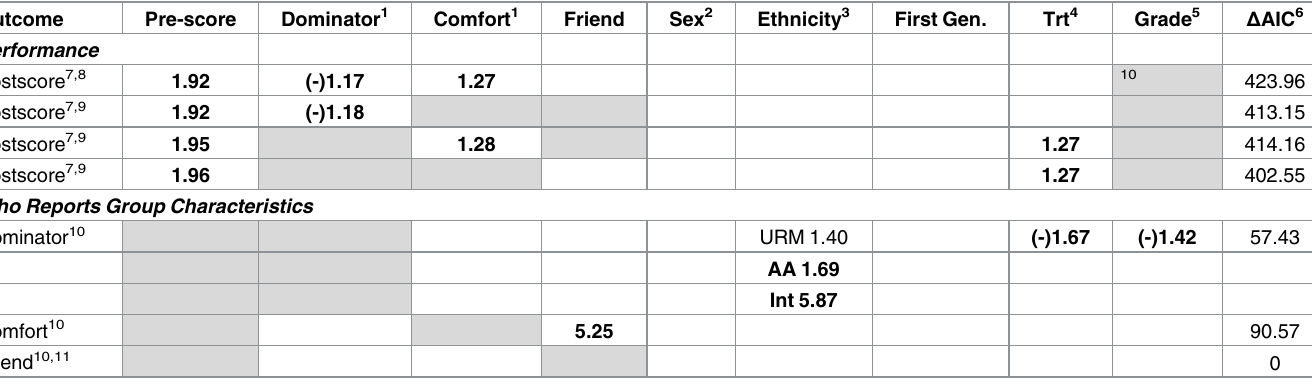
Table 2. Final models and associatedestimatesfor predicting students’ performanceon the post-test and which students report a dominator, being comfortable, and working with a friend. Coefficients are presentedas odds (transformed from logodds); models were fit as cumulativelink mixed models (postscore, dominator, comfort) or logistic regression (friend; see methods for details). Boldedcoefficients represent statistical significanceto α = 0.05. Grey cells indicatevariablesthat were not includedin the full model, empty cells indicatevariablesthat were includedin the full model and then were droppedduringthe model selectionprocess. Superscriptednotes indicate starting models and